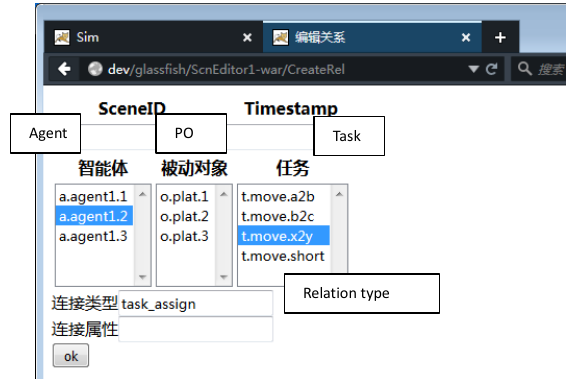
Figure 6. Scenario Editor UI of Task